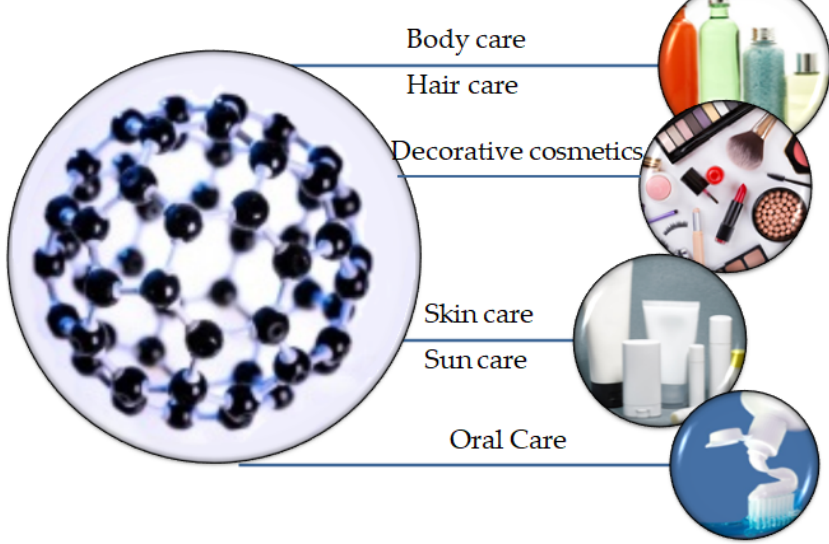
Figure 1. Nanomaterials in various cosmetic applications.